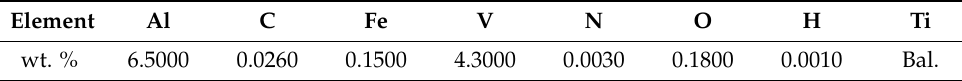
Figure 1. SEM image of Ti-6Al-4V. Table 1. Chemical composition of the titanium alloy powder.